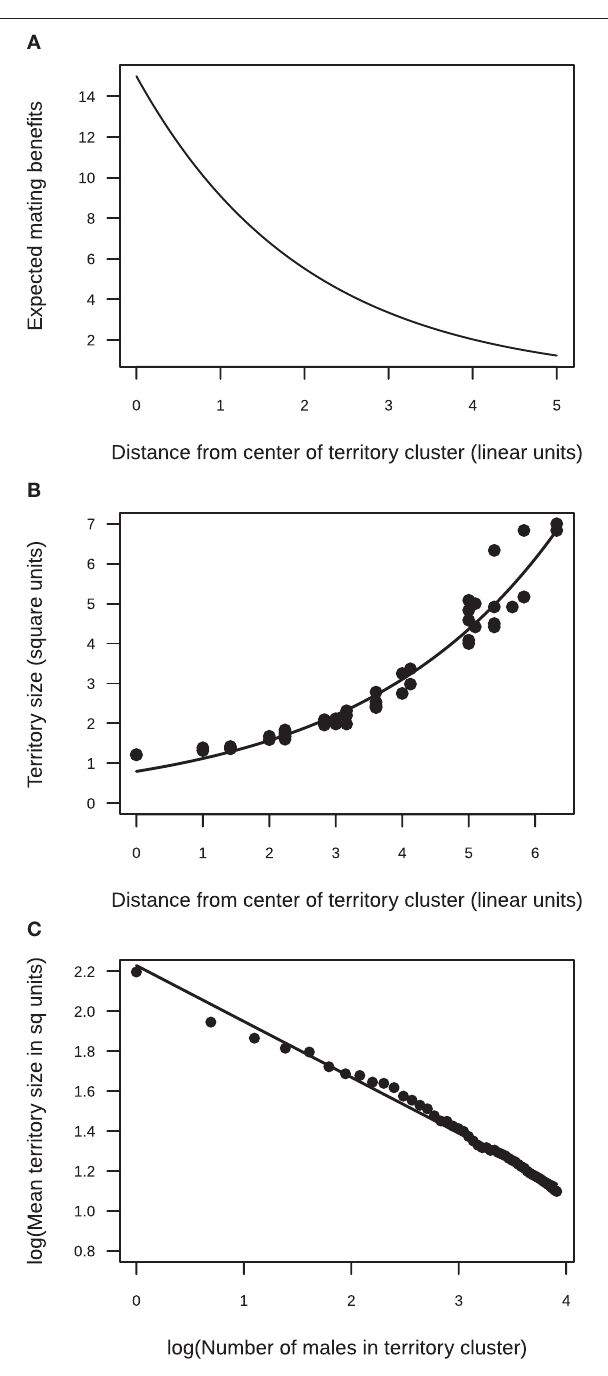
FIGURE 1 | Results from the simulation model of the effect of a female preference to mate in the center of an aggregation on territory size. (A) Mating benefits were assumed to decline exponentially from the center of the aggregation to the periphery (exponent = 0.5). (B) The model predicts that, within a cluster, territory size should increase from the center to the periphery. An example is shown for a cluster of 50 territorial males (the line shows the fit of an exponential function Y = 0.8 e 0.34 X ). (C) The model predicts that, across clusters varying in size, mean territory size should decrease non-linearly with cluster size [as indicated by the slope of the log-log plot, log( Y ) = 2.22 – 0.28log( X